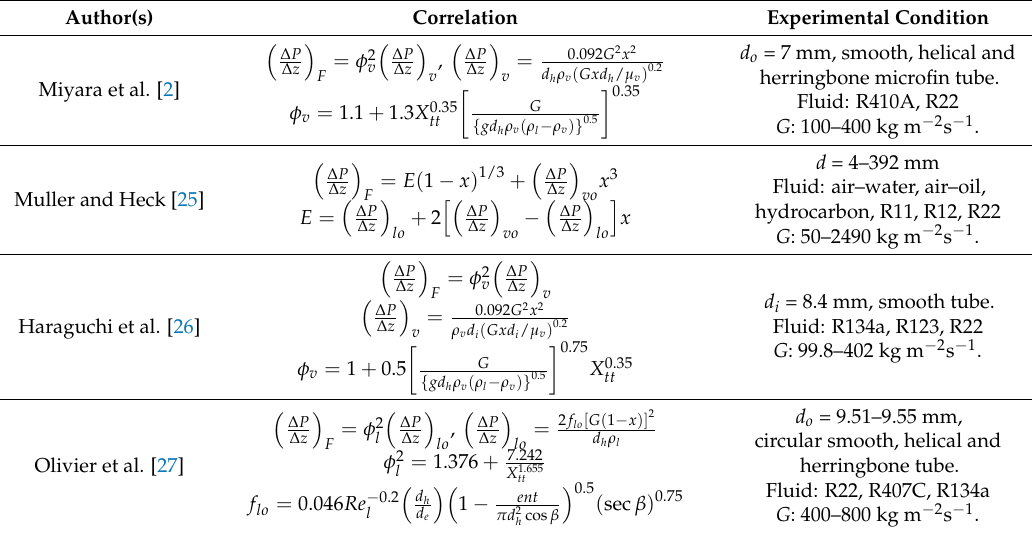
Table 3. Pressure drop correlations.